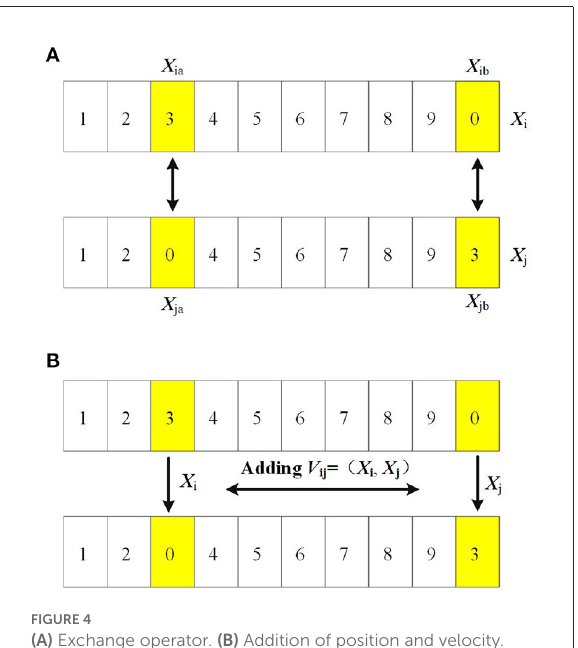
FIGURE4 (A) Exchange operator. (B) Addition of position and